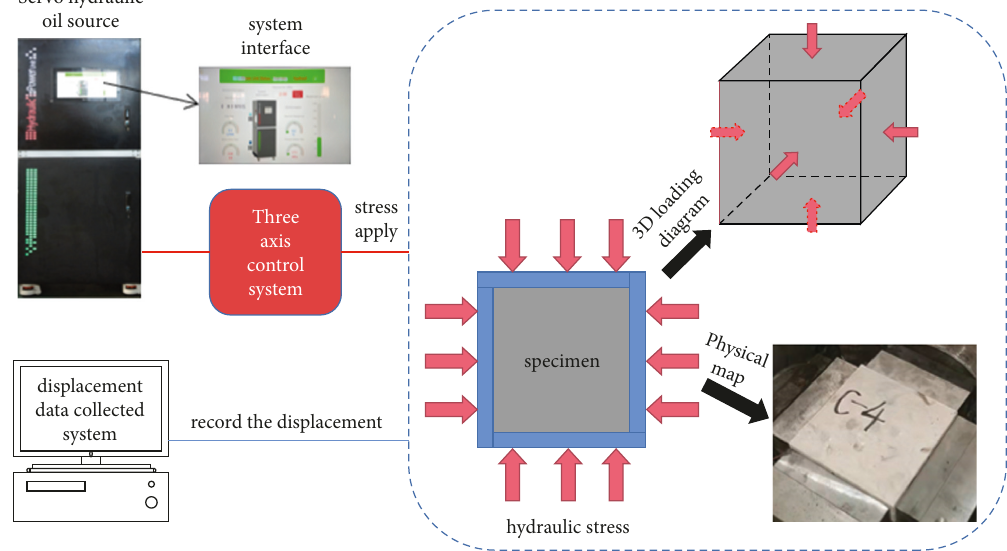
Figure 2: Principle of rock mechanics test system.